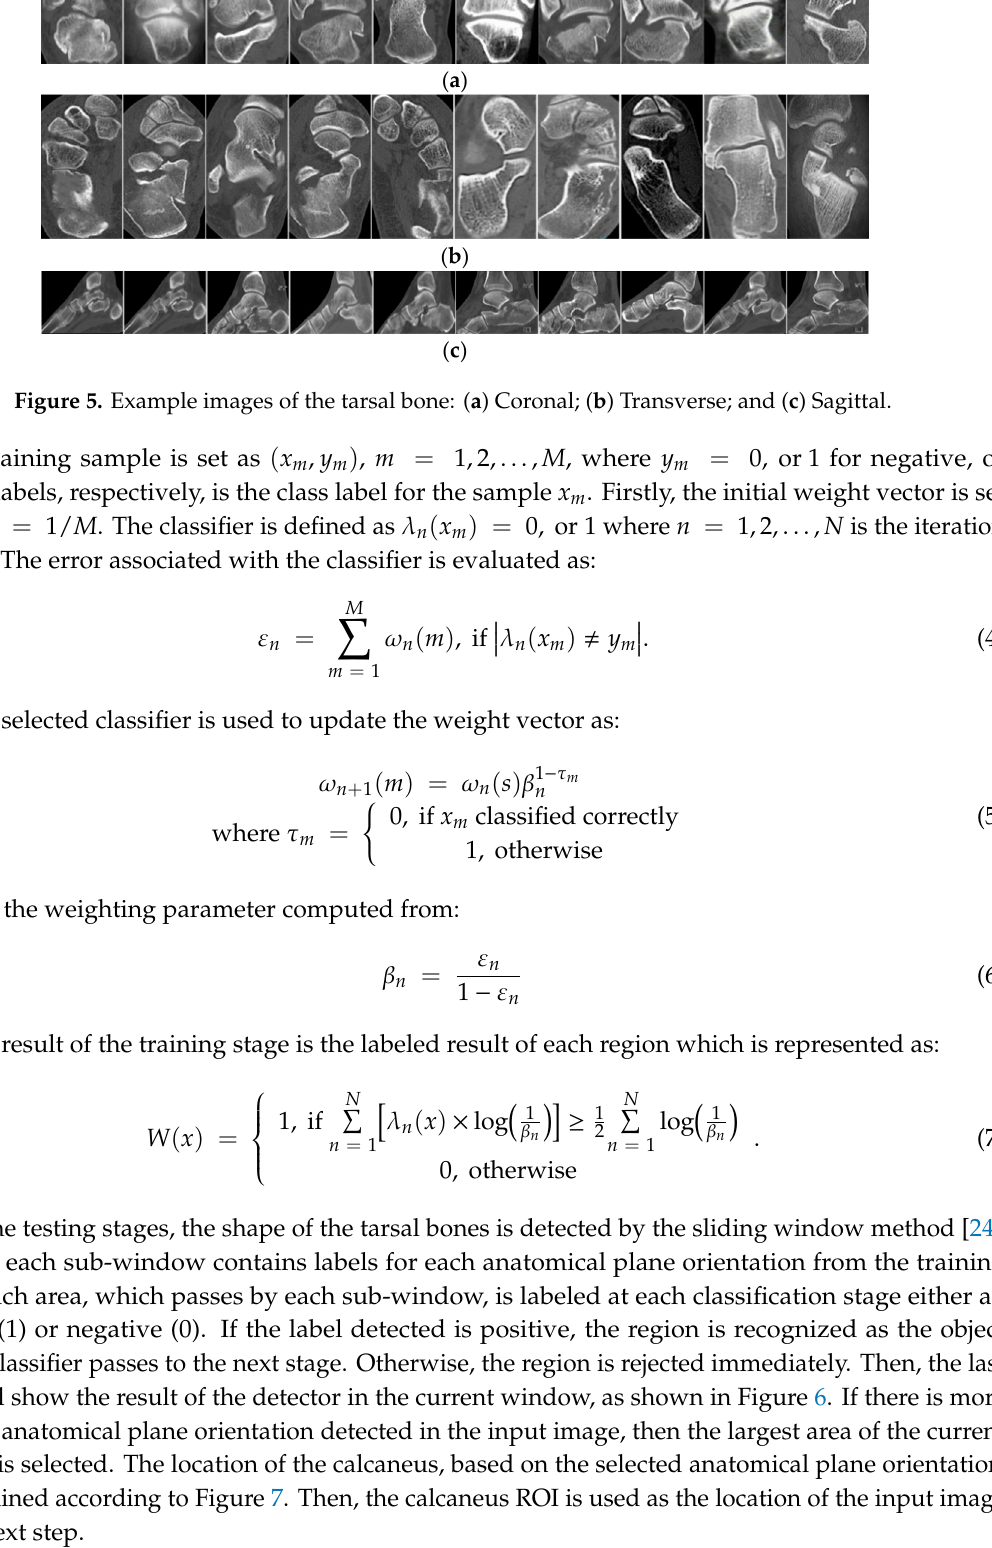
Figure 4. Input image region.